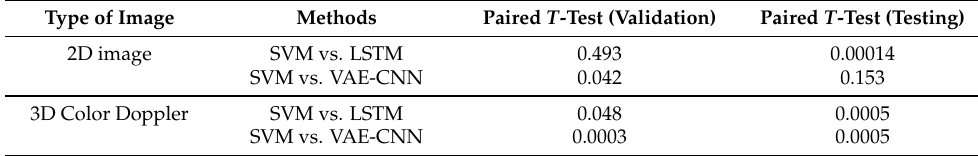
Table 3. Statistical test for comparing methodologies without k fold cross